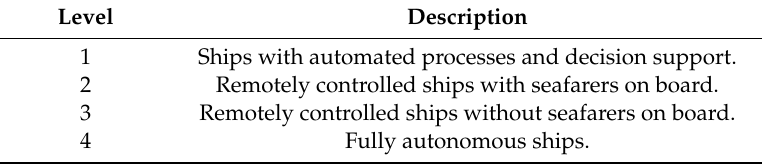
Table 3. MASS Levels of Control according to IMO in the frame of a regulatory scoping exercise from 2018